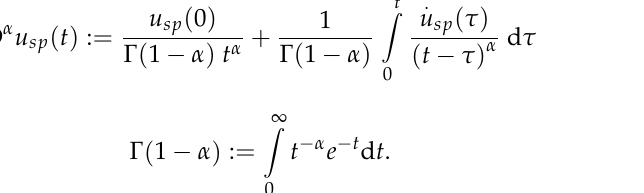
Figure 11. Curve fitting results for two analyzed UBM (042 and 045) models using two different procedures DIN [23] and EN [24].